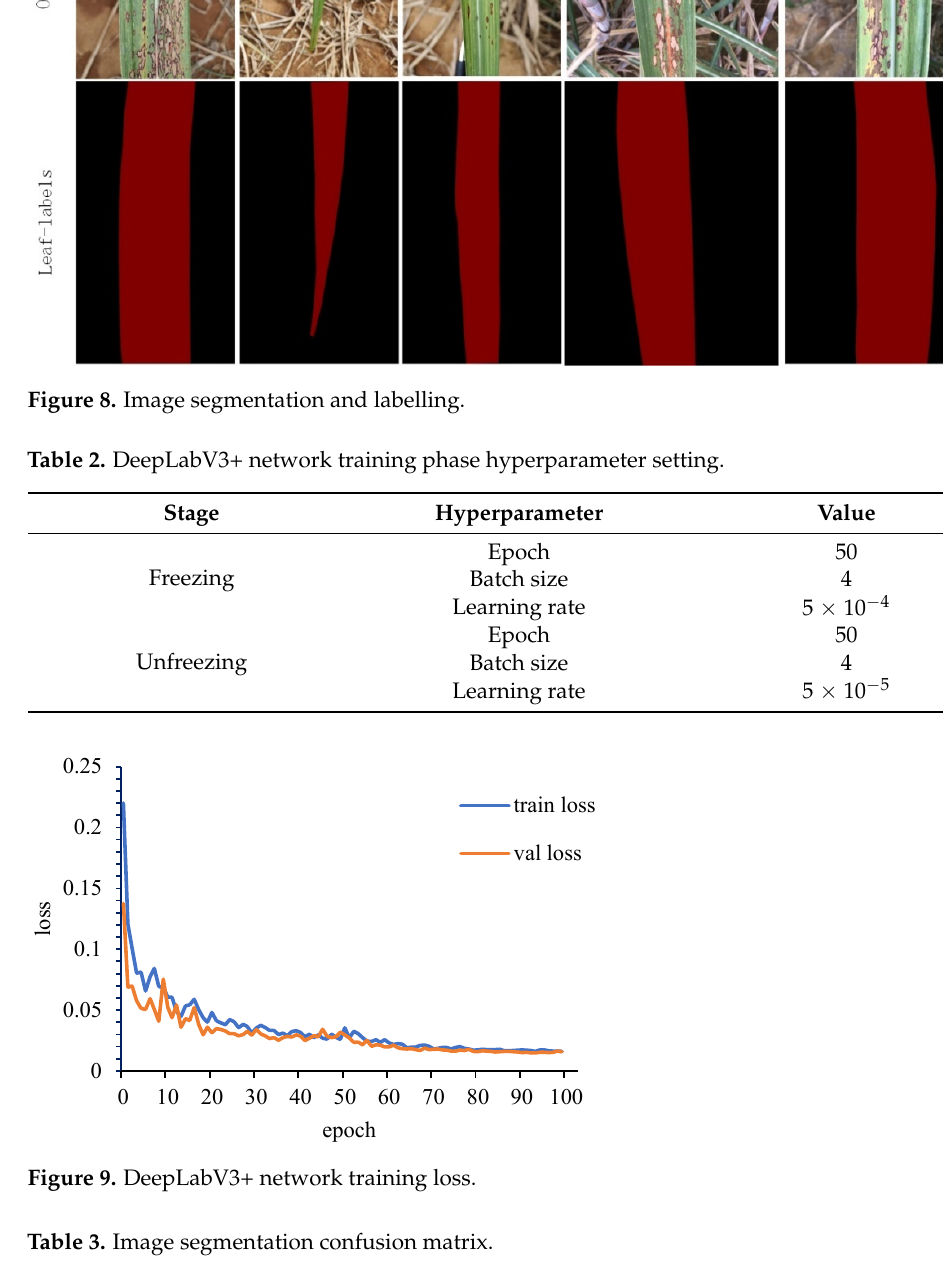
Figure 8. Image segmentation and labelling.